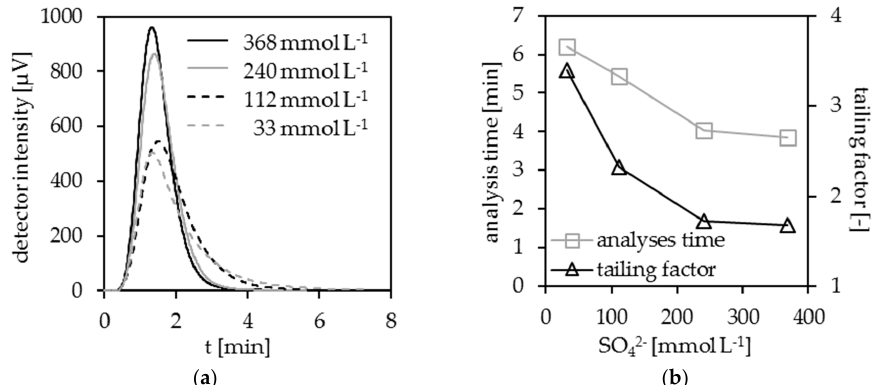
Figure 4. ( a ) Decomposition of pyridine as a function of the sulfate concentration; ( b ) peak